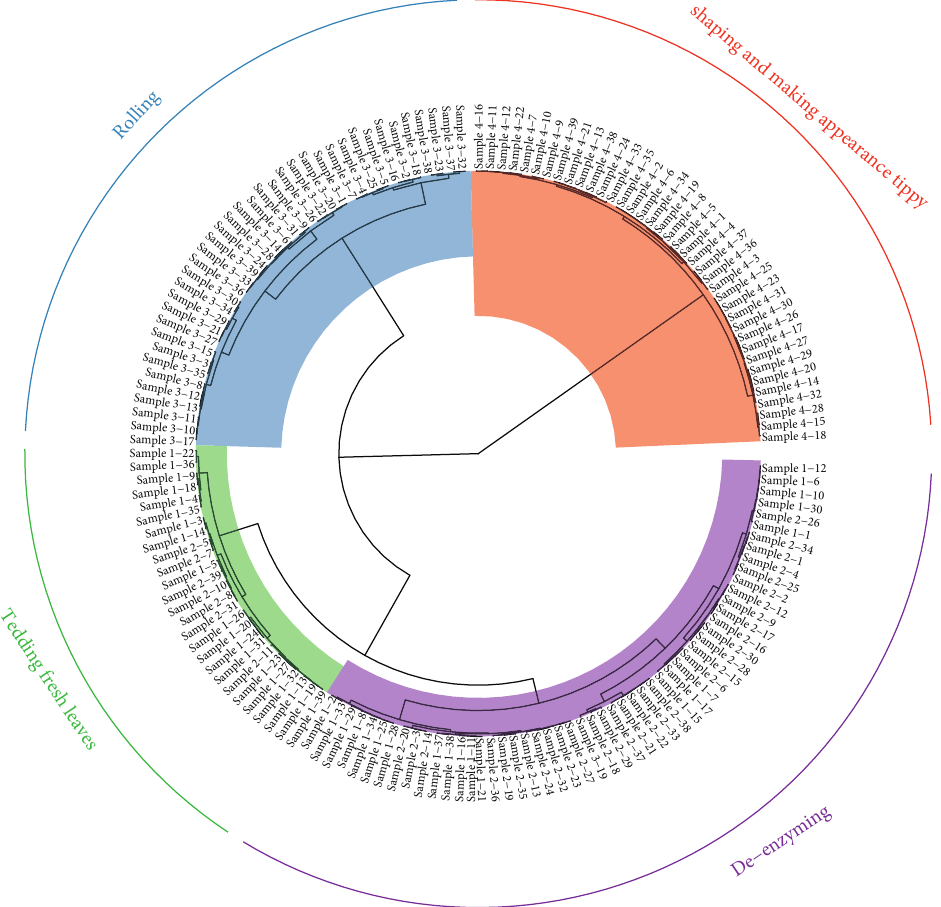
Figure 5: Cluster analysis of tea